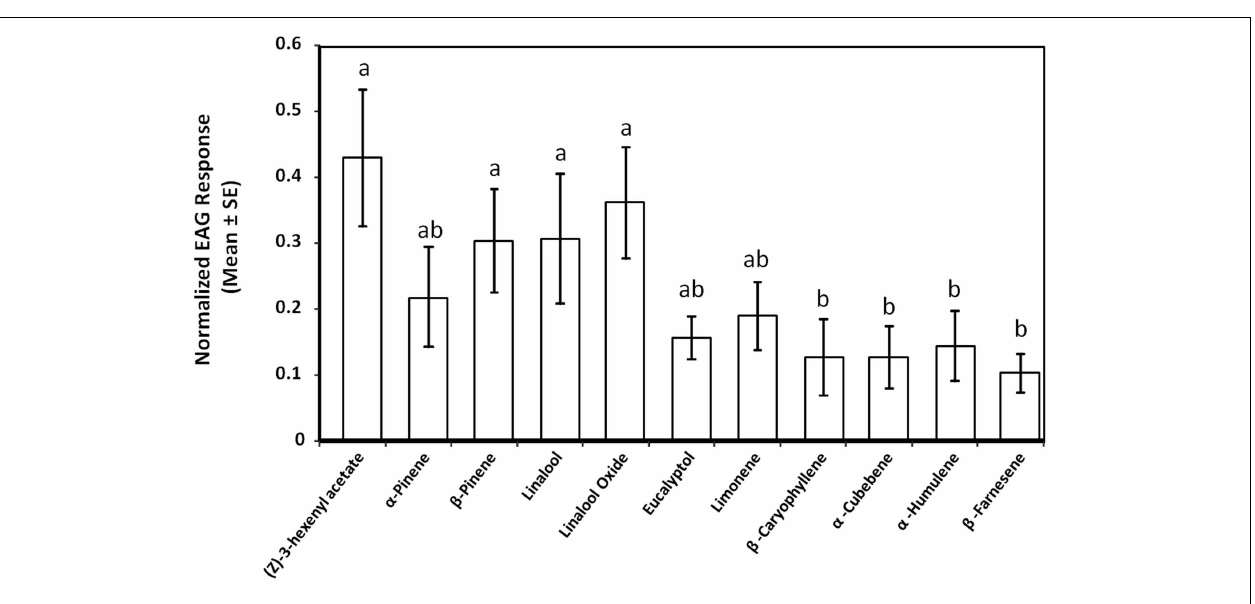
were subtracted from the test stimuli values. Different letters indicate significant differences among means ( P ≤ 0.05). Results of male and female S. sulfureana responses were combined in the graph ( N =